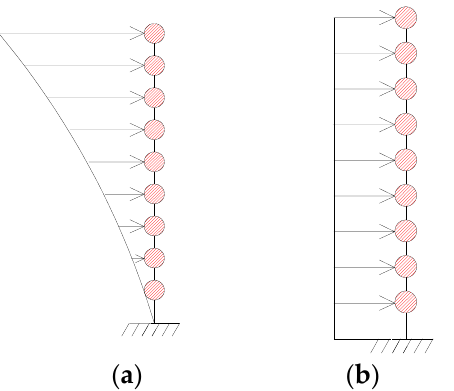
Figure 6. Lateral load distributions: ( a ) parabolic distribution (LD-P) and ( b ) uniform distribution